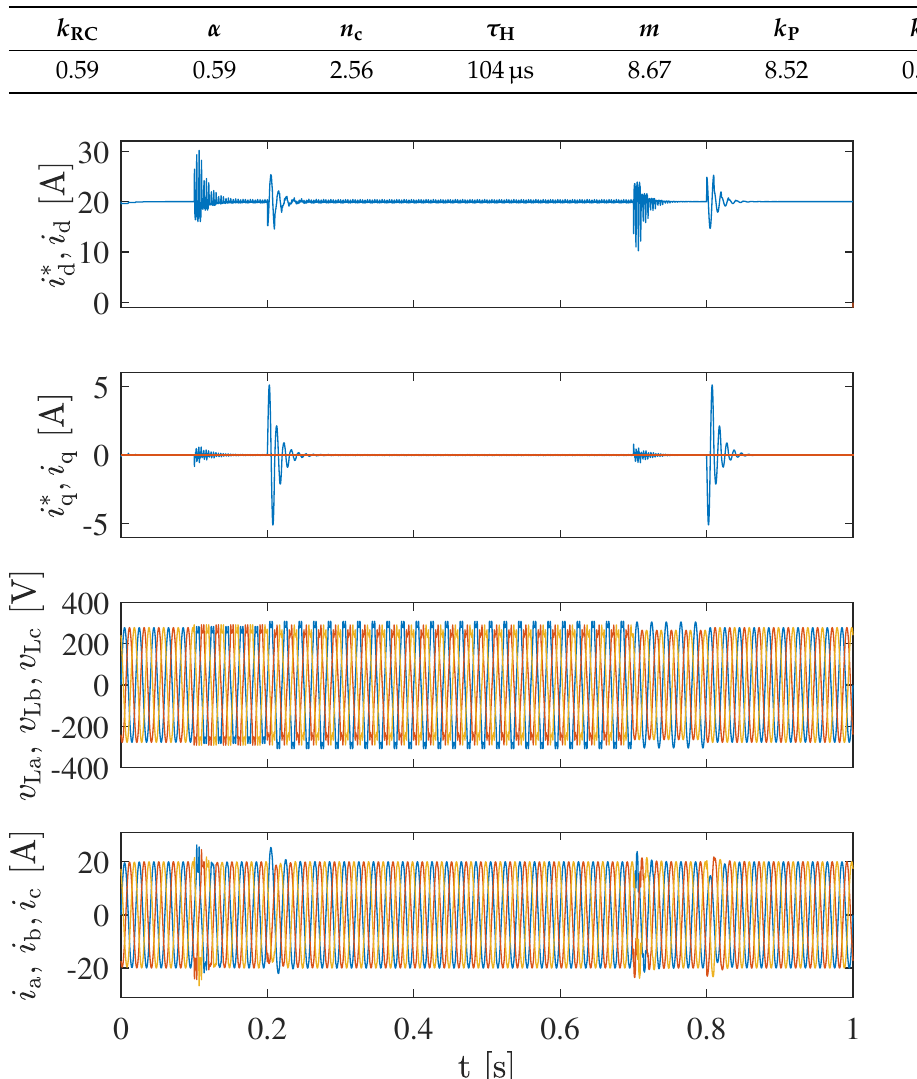
Figure 11. Reference (red) and real (blue) currents in the dq system, grid voltages and currents in the abc